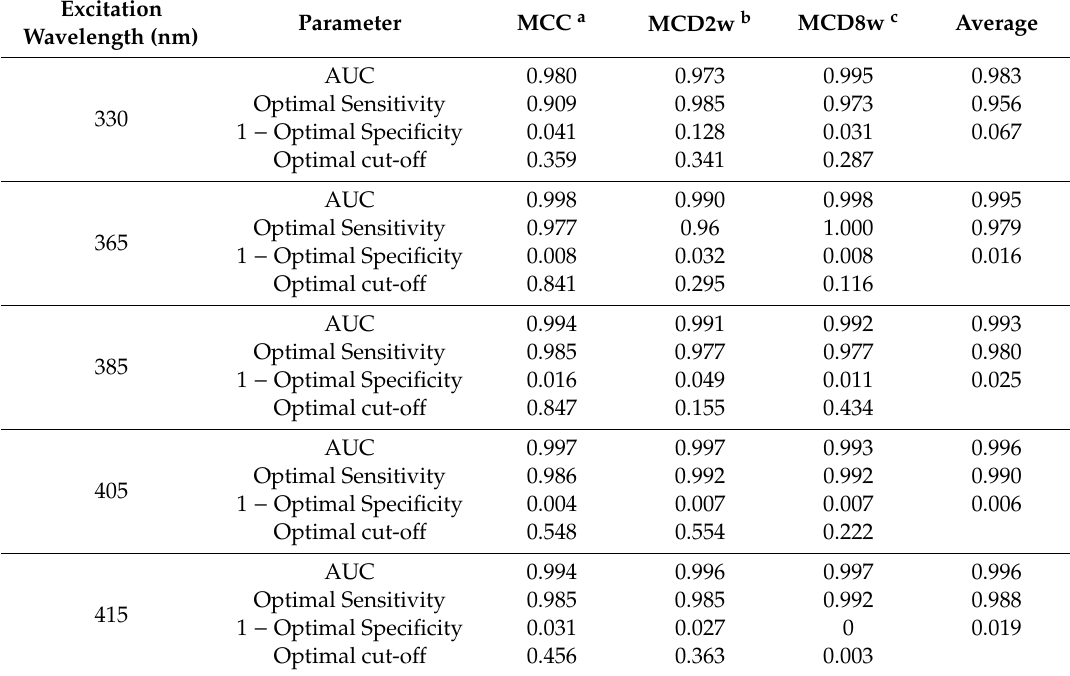
Table 4. Area under the curve (AUC) for the ROC curves, together with the indexes that asses the performance of fluorescence spectroscopy as a diagnostic tool of liver-steatosis degree, obtained from the spectra recorded under each excitation wavelength in every of the three classification